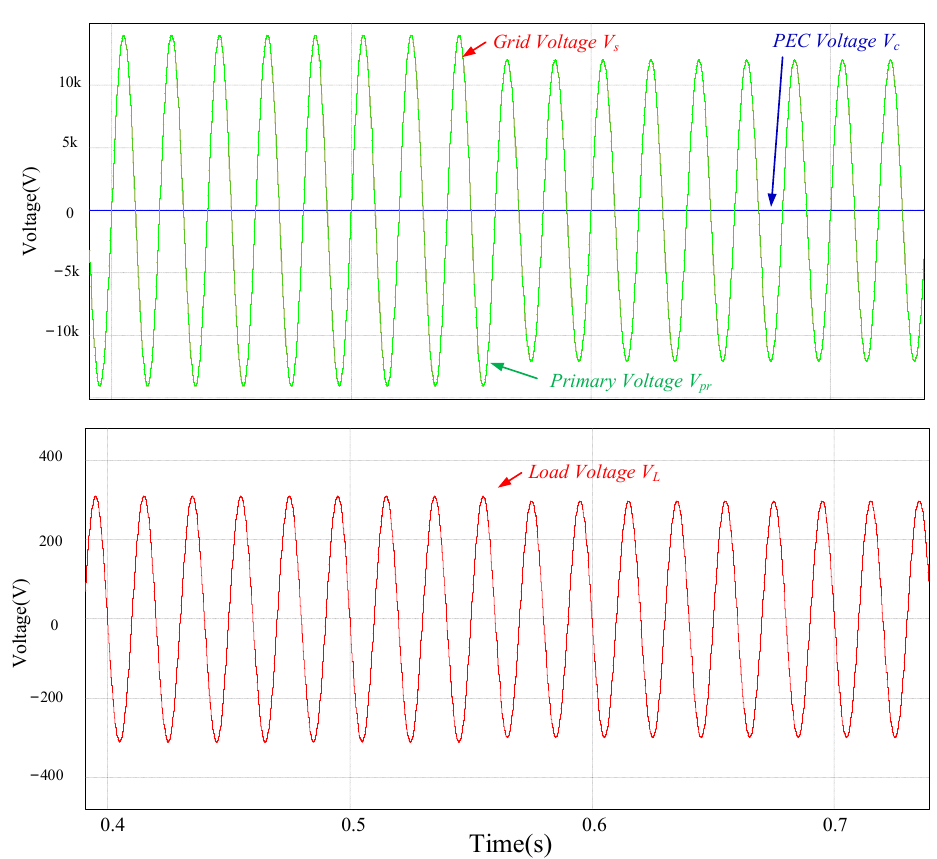
As can be seen from the figure, the traditional stepwise voltage regulation method can realize the rough regulation of load voltage but cannot realize the accurate regulation of load voltage.